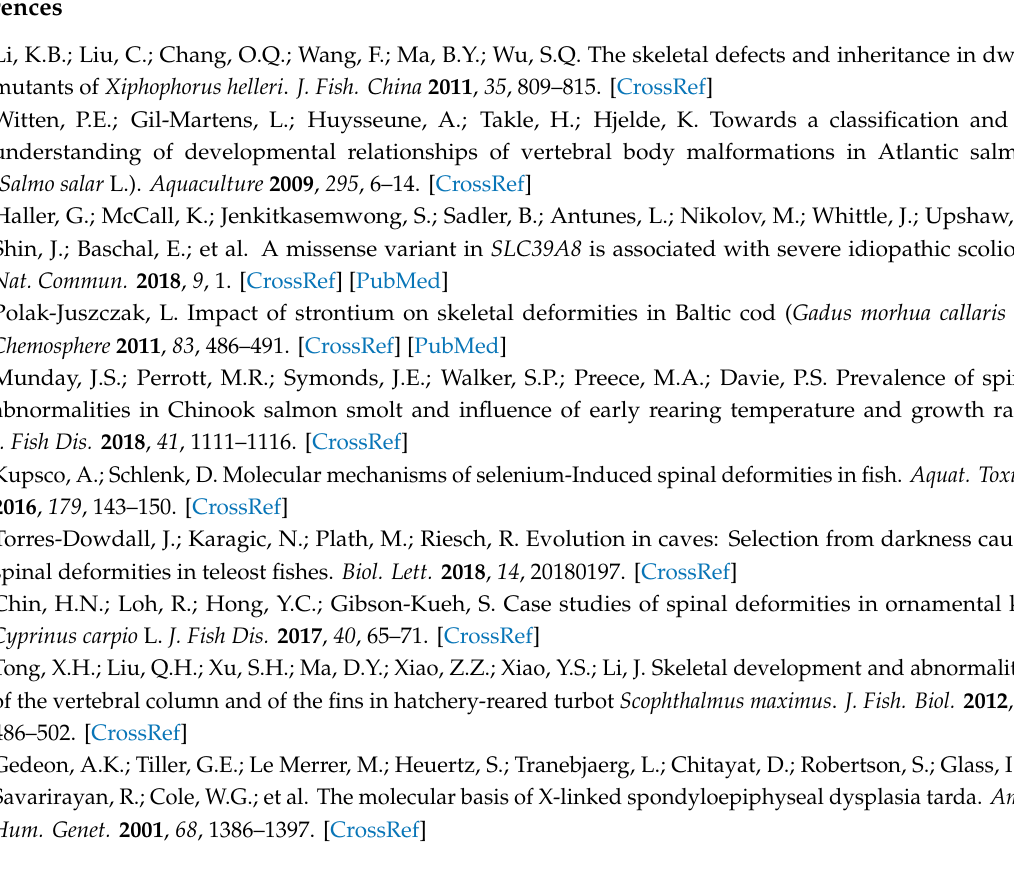
Table S1: The primer sequences for quantitative real-time PCR. Table S2: Summary of high-throughput sequencing data and quality control. Table S3: Significant SNPs associated with TL / H and candidate genes. Table S4: Estimated variance explained by the significant SNPs. Figure S1: Linkage disequilibrium (LD) decay distance of the